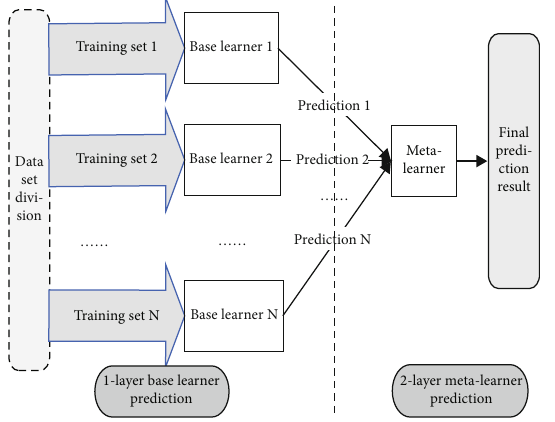
Figure 2: Ensemble learning method based on